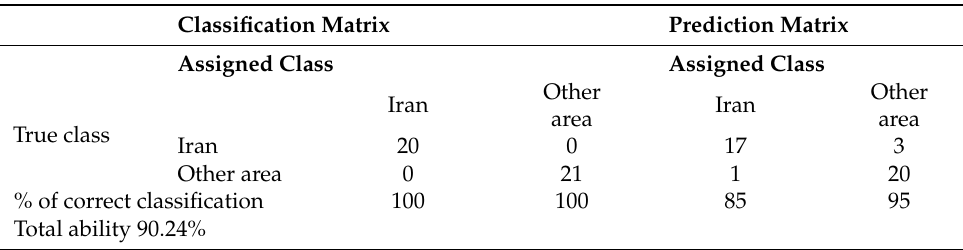
Table 3. Confusion matrices displaying the classification performance of QDA applied to saffron extract samples from two geographical origins.